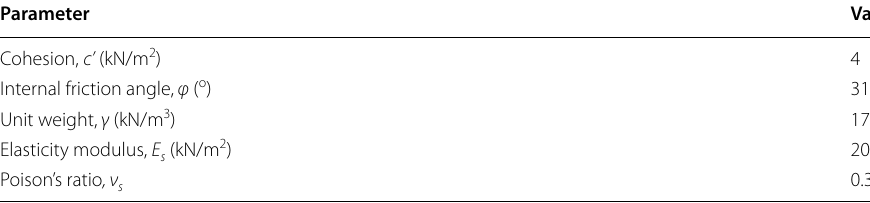
Table 2 In‑situ soil parameters Parameter